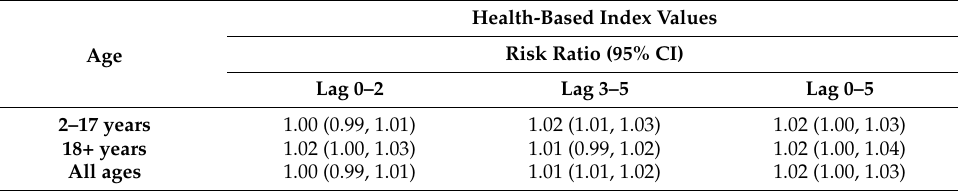
Table 3. Risk ratios for respiratory emergency department visits in Mexico City associated with health-based index values, by age group and lag structure. The primary exposure period of interest is the 6-day average observed at lag days 0–5. Significant associations were observed for both children and adults for the critical time period at which health effects were observed across the range of individual pollutants evaluated in this